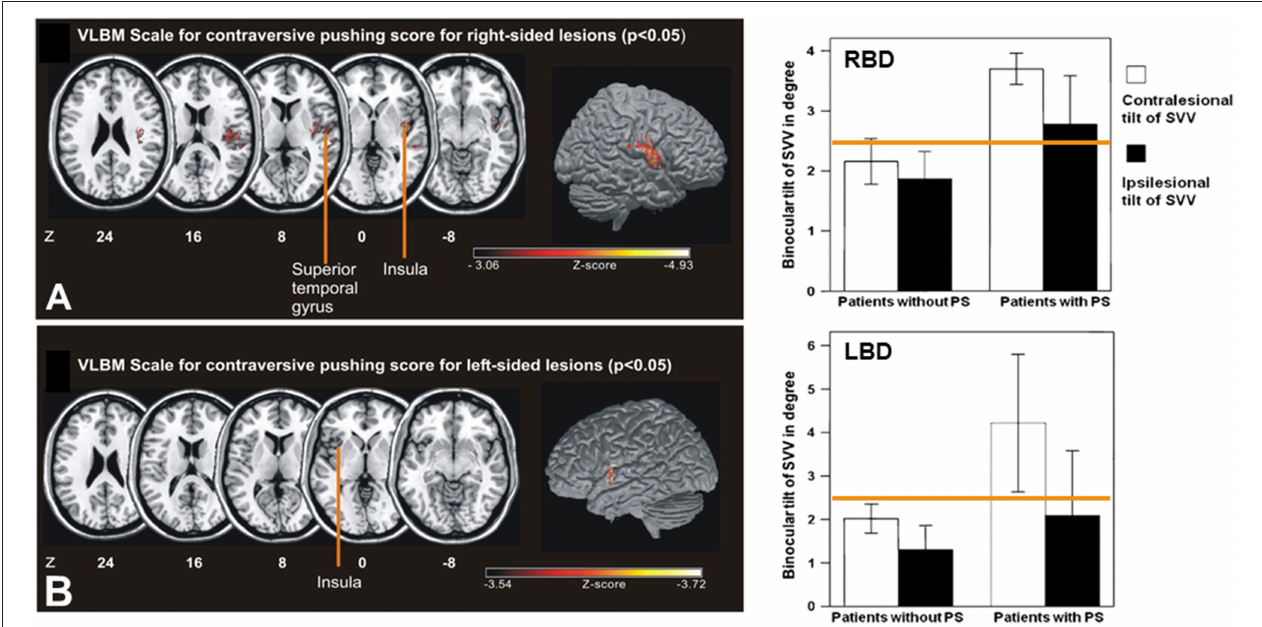
FIGURE 7 | Lesion sites of acute hemispheric infarctions that cause pushing behavior. Left: Statistical voxelwise lesion-behavior mapping (VLBM) multiple regression analysis of the right-sided lesion patients ( A : RBD; top) and left-sided lesion patients ( B : LBD, bottom) with predictors including the Scale for Contraversive Pushing (SCP) and lesion size. The key areas of the lesion covered the posterior insular cortex, the superior temporal gyrus, and white matter in RBD. The key areas in LBD associated with the extent of contraversive pushing were the anterior insular cortex as well as parts of the operculum and the internal capsule reaching to the lateral thalamus (not shown here). Talairach z-coordinates of each transverse section are given. Right: Mean amplitude of SVV in RBD and LBD without and with pusher syndrome (PS). Significance was not obtained ( p > 0.05) for either the contra- or the ipsilesional tilt of SVV. Error bars indicate standard error of the mean. Yellow line indicates normal range for SVV measurement [adopted in part from Baier et al. ( 37)].